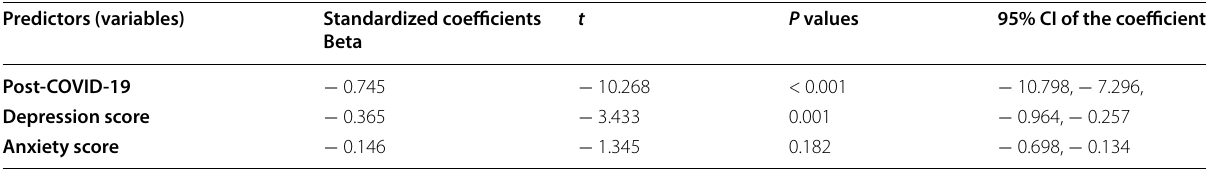
Table 9 A multiple linear regression considering attention score variable as an outcome while predictors are post‑COVID‑19, depression score, and anxiety